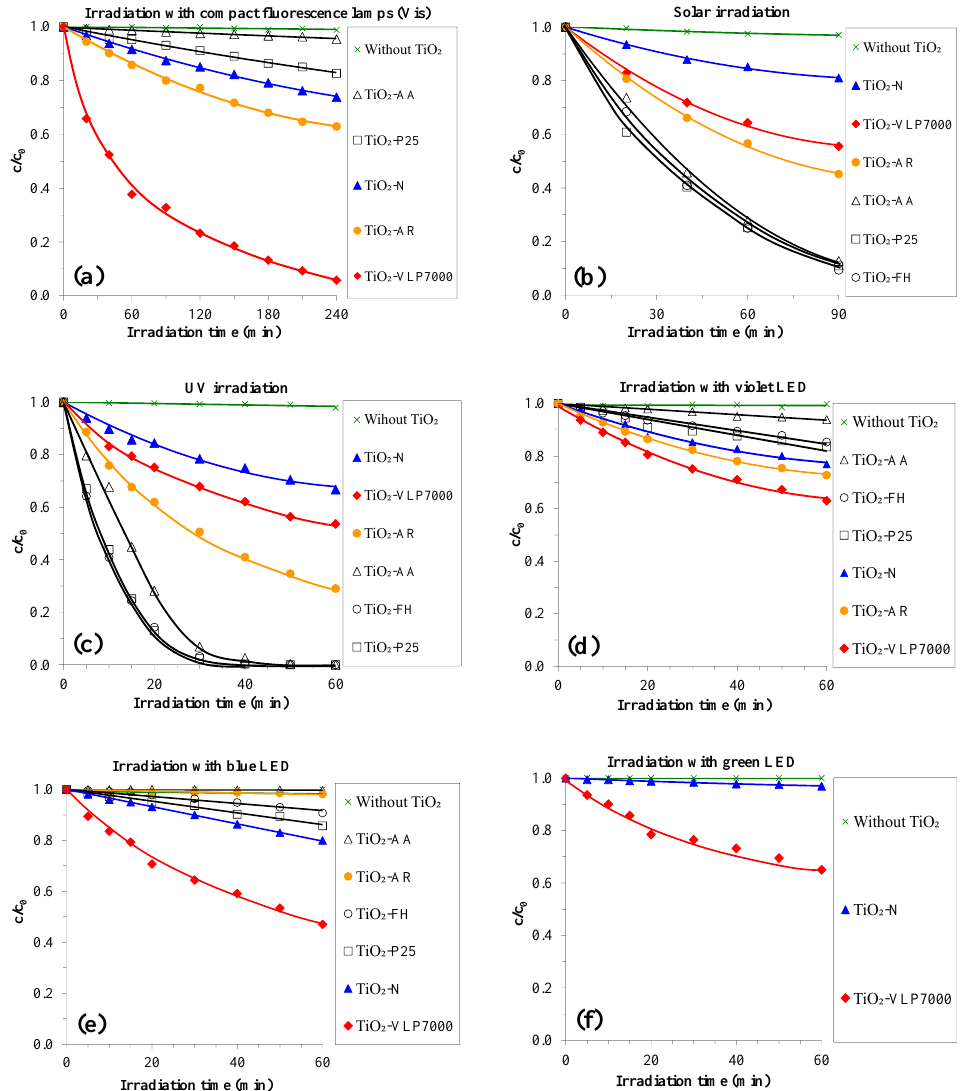
Figure 1. Photocatalytic phenol decomposition (c phenol = 0.1 mM, c TiO2 = 1.0 g·L − 1 ) applying ( a ) energy-saving compact fluorescence lamps, ( b ) natural solar irradiation, ( c ) UV-A irradiation, ( d ) violet irradiation, ( e ) blue irradiation, and ( f ) green irradiation.